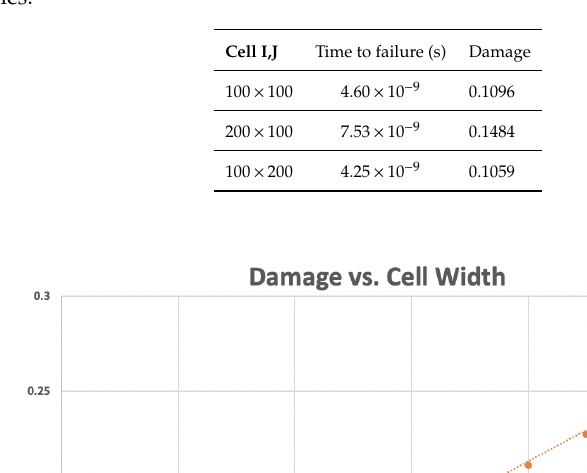
(cid:73) SCM ) (100x100) leads to large changes in the (cid:73) SCM leads to much smaller changes in